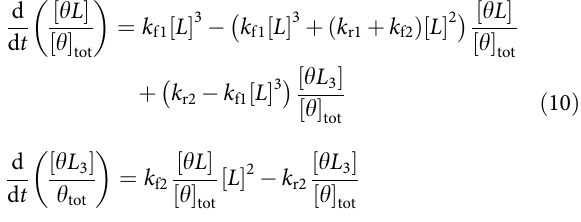
(Supplementary Fig. 6, dashed blue curve) to a pure fibrinogen solution, the positions of the two major peaks remain invariant, indicating that the SWCNT corona phase did not catalytically denature the fibrinogen protein 60 .